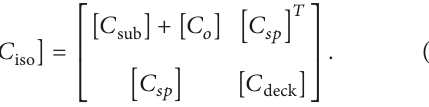
surface of the FPD was also carried out. In